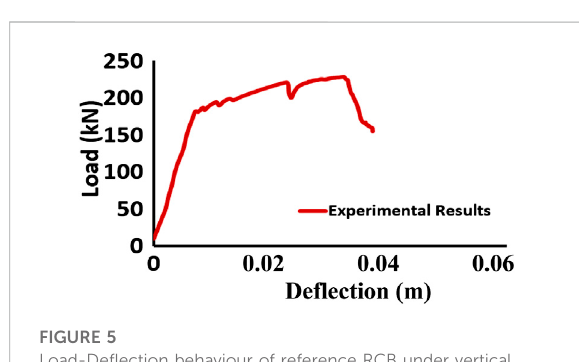
FIGURE 5 Load-De fl ection behaviour of reference RCB under vertical